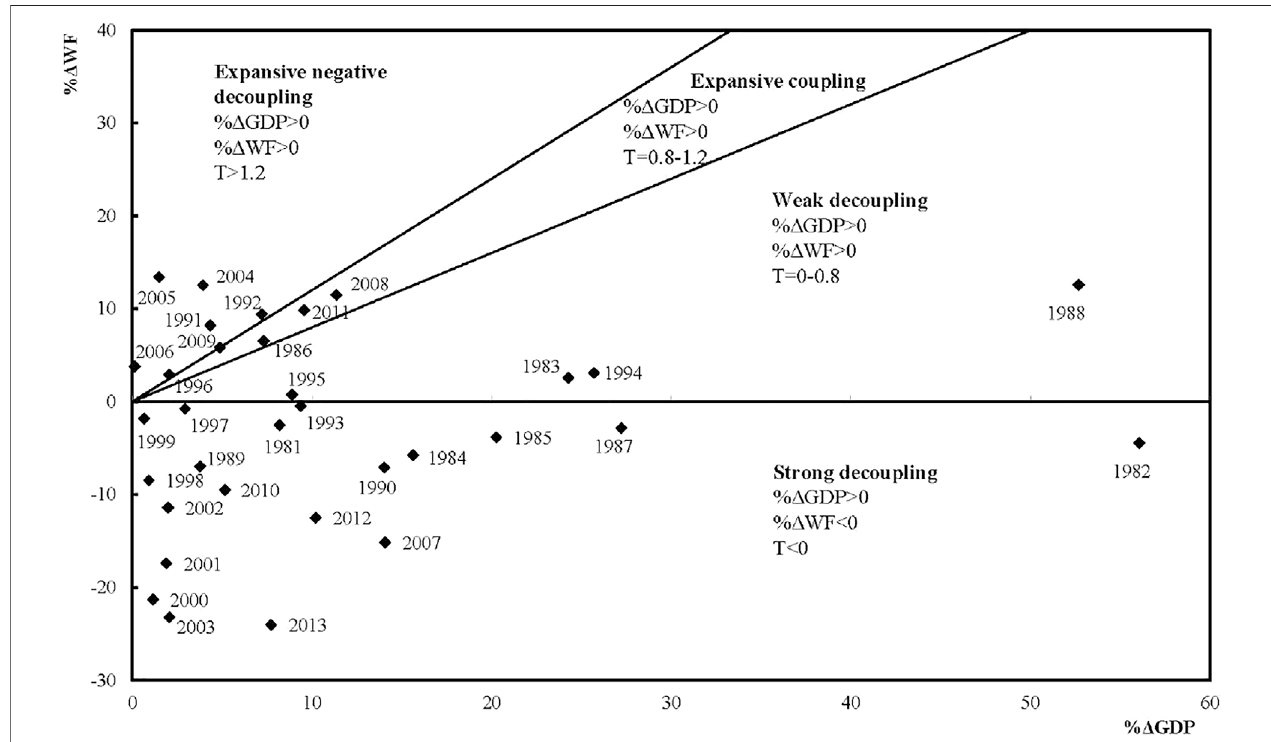
FIGURE 3 | The degrees of coupling and decoupling of WF growth from agricultural GDP growth (based on Tapio).